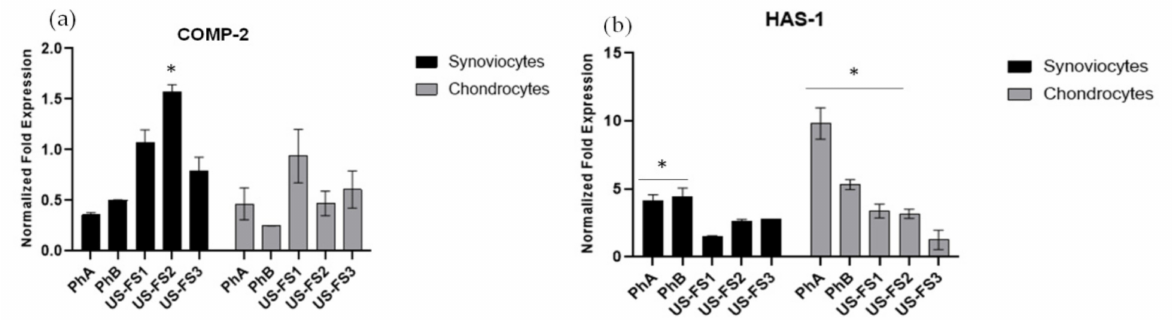
Figure 4. Gene expression analyses normalized respect to pathological untreated cells (pCTR) for the analyses of COMP-2 ( a ) and HAS-1 ( b ) on chondrocytes and synoviocytes, treated with US FDA approved FS in comparison to PhA and PhB samples at 6 h of incubation. The values presented are the averages ± S.D. Significant differences are indicated as * p < 0.01 vs.